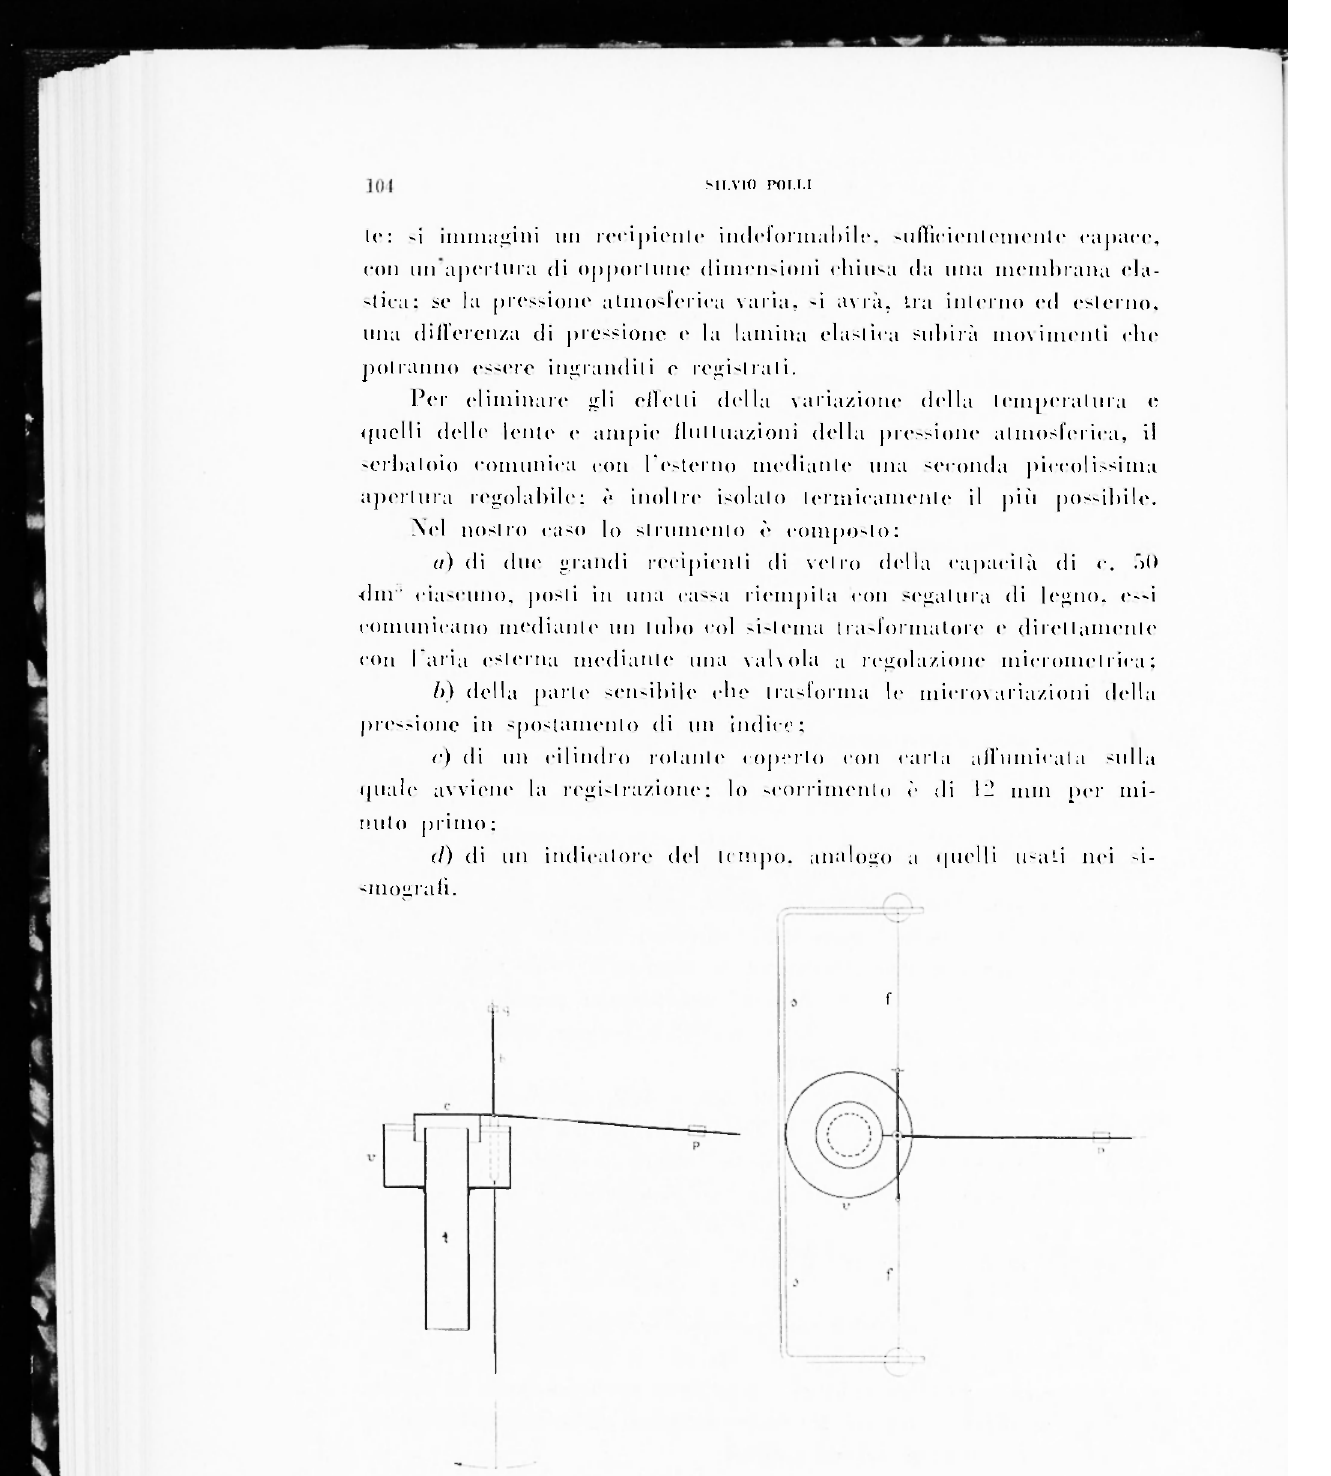
Fig. I Sezione p'anlu del sistema